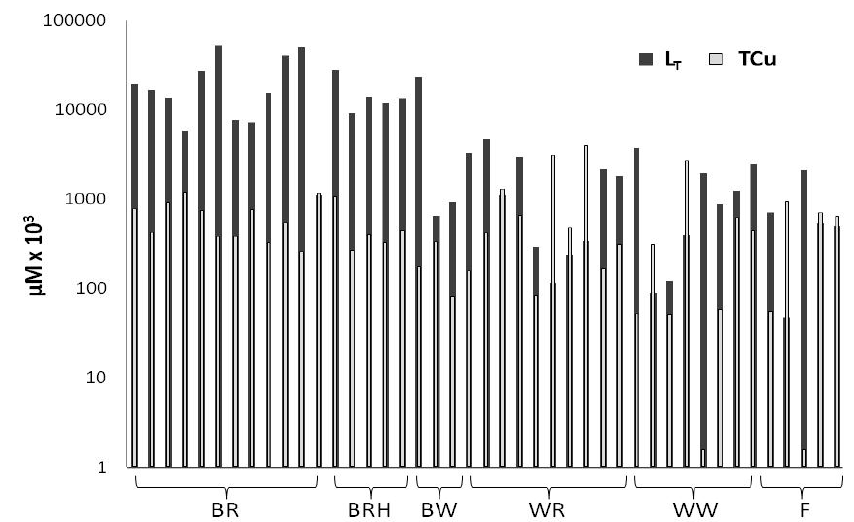
Figure 1. L T and TCu concentrations (logarithmic scale) in vinegars (BR: balsamic red vinegar, n = 12; BRH: balsamic red vinegar with honey, n = 5; BW: balsamic white vinegar, n = 3; WR: wine red